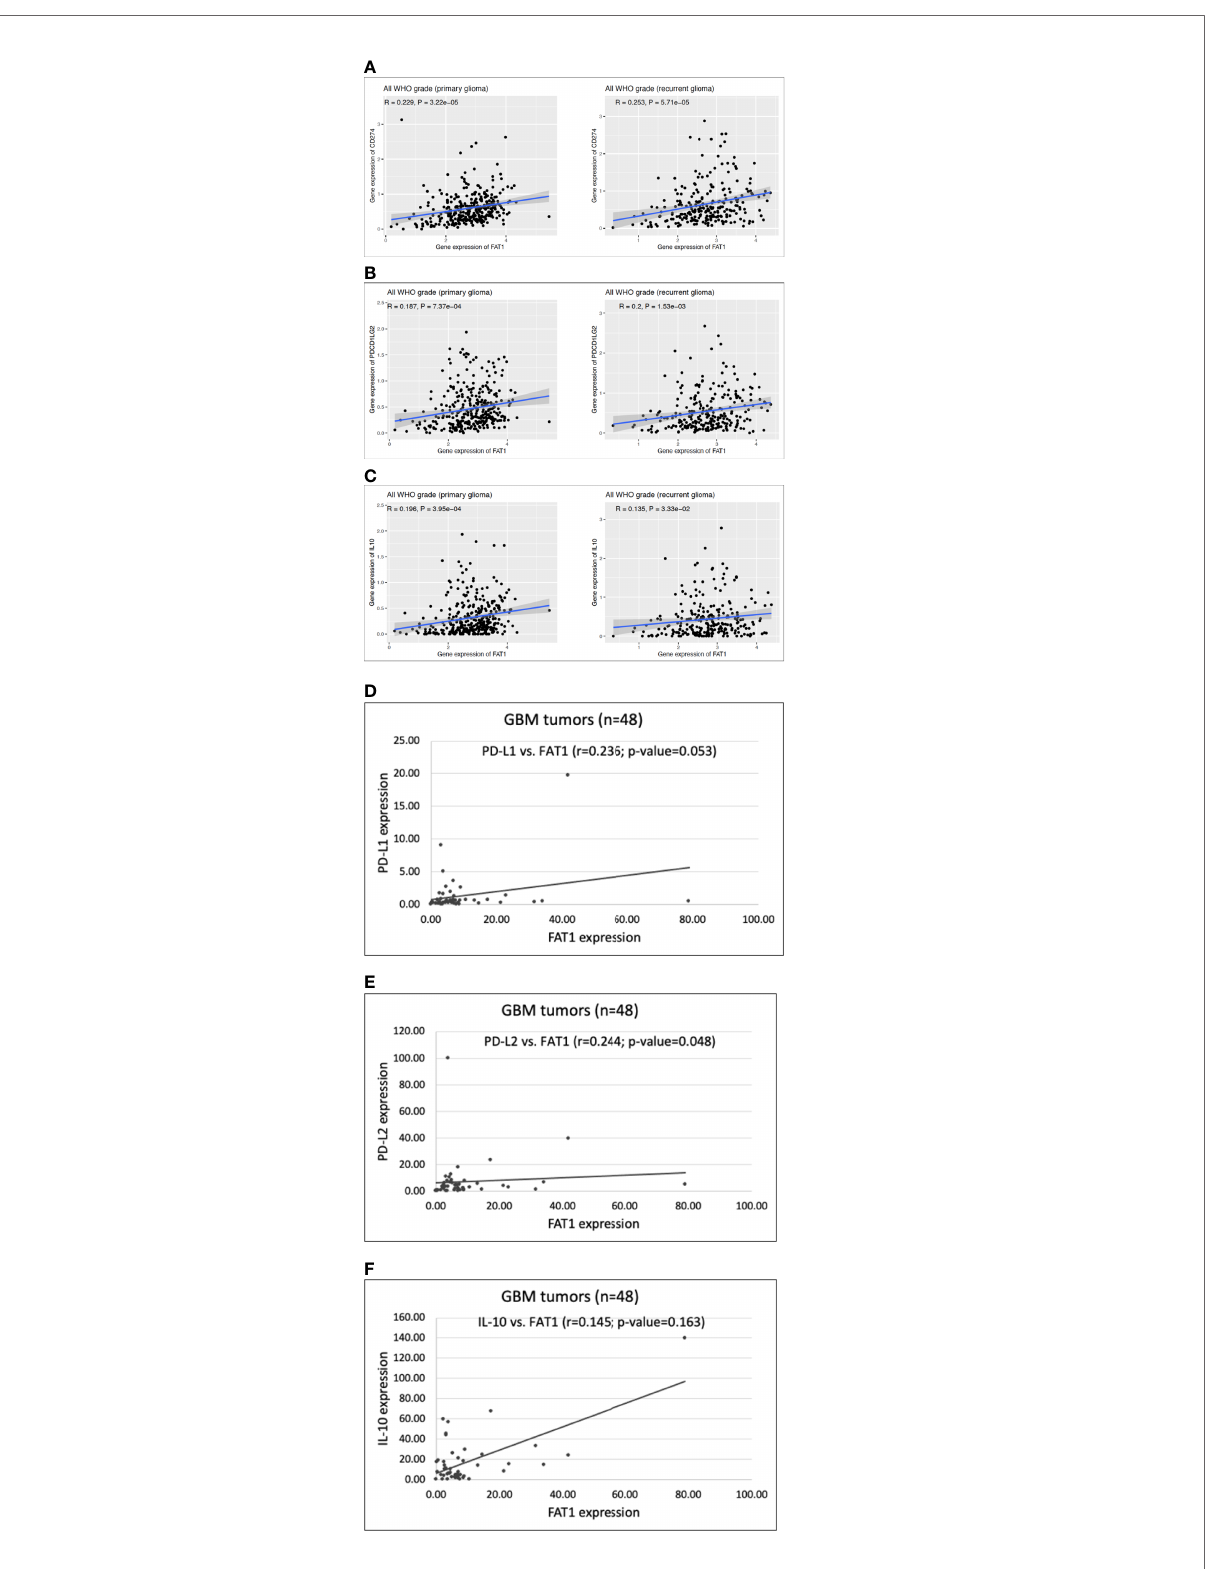
FIGURE 6 | (A – C) Scatter plots showing correlation of FAT1 expression with expression of PD-L1 (CD274), PD-L2 (PDCD1LG2) and IL-10 in primary and recurrent glioma cases belonging to CGGA database (dataset: mRNAseq_693). (D – F) Scatter plots showing correlation of FAT1 expression with expression of PD-L1, PD-L2 and IL-10 in GBM tumor specimens (n=48) as analysed by